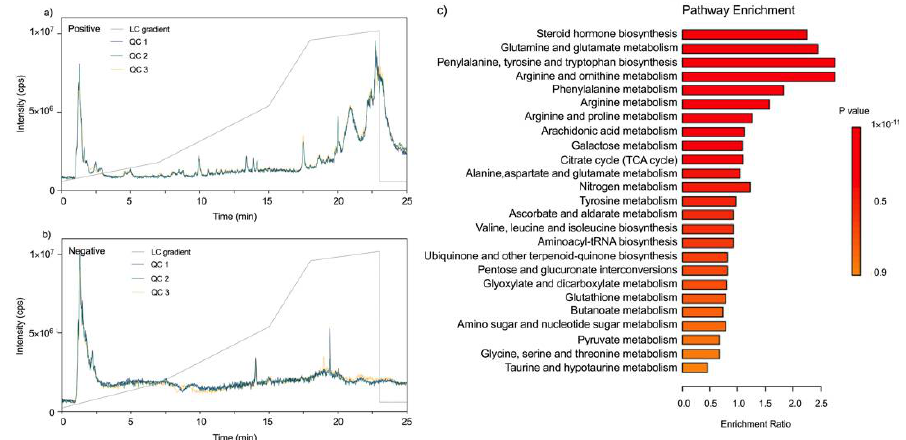
Figure 1. The LC-MS total ion current chromatograph (TIC) of QC samples in the positive mode ( a ) and negative mode ( b ), the dotted lines show the LC gradient in B phase percentage. ( c ) Top 25 metabolic pathways enriched in children CSF samples by untargeted metabolomic analysis.